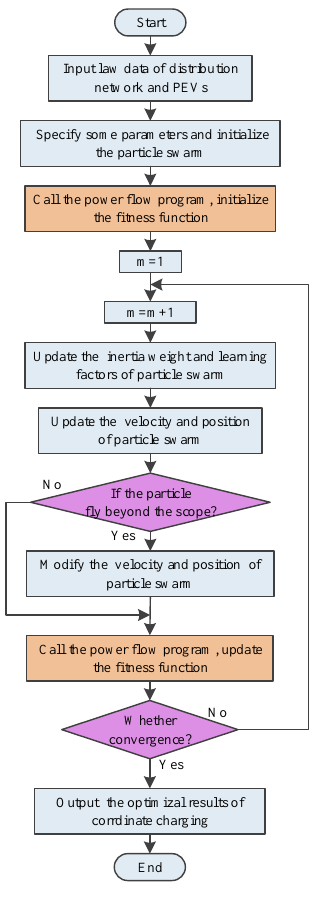
Figure 3. The coordinated charging of PEVs based on the PSO algorithm.